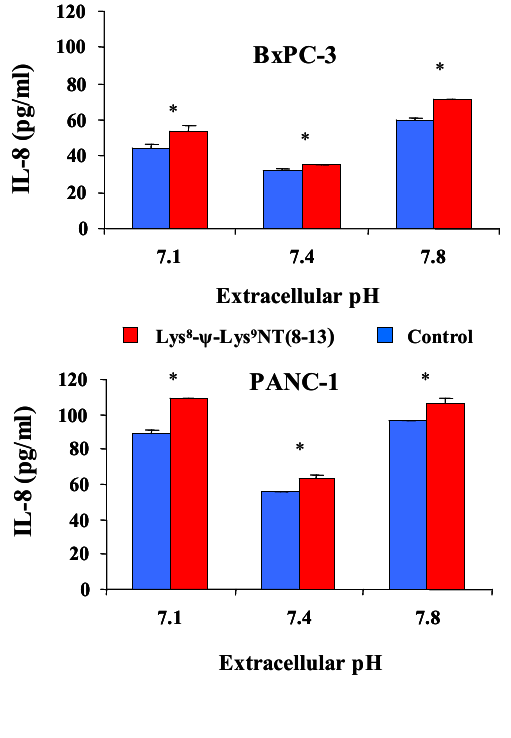
Figure 5. Concentrations of IL-8 in culture supernatants of untreated or Lys8- ψ -Lys9NT (8-13)-treated BxPC-3 (top) and PANC-1 (bottom) cells in dependence of different extracellular pH conditions. Data are presented as mean ± SD of duplicate measurements (differences between medium and NT-supplemented samples: * p <